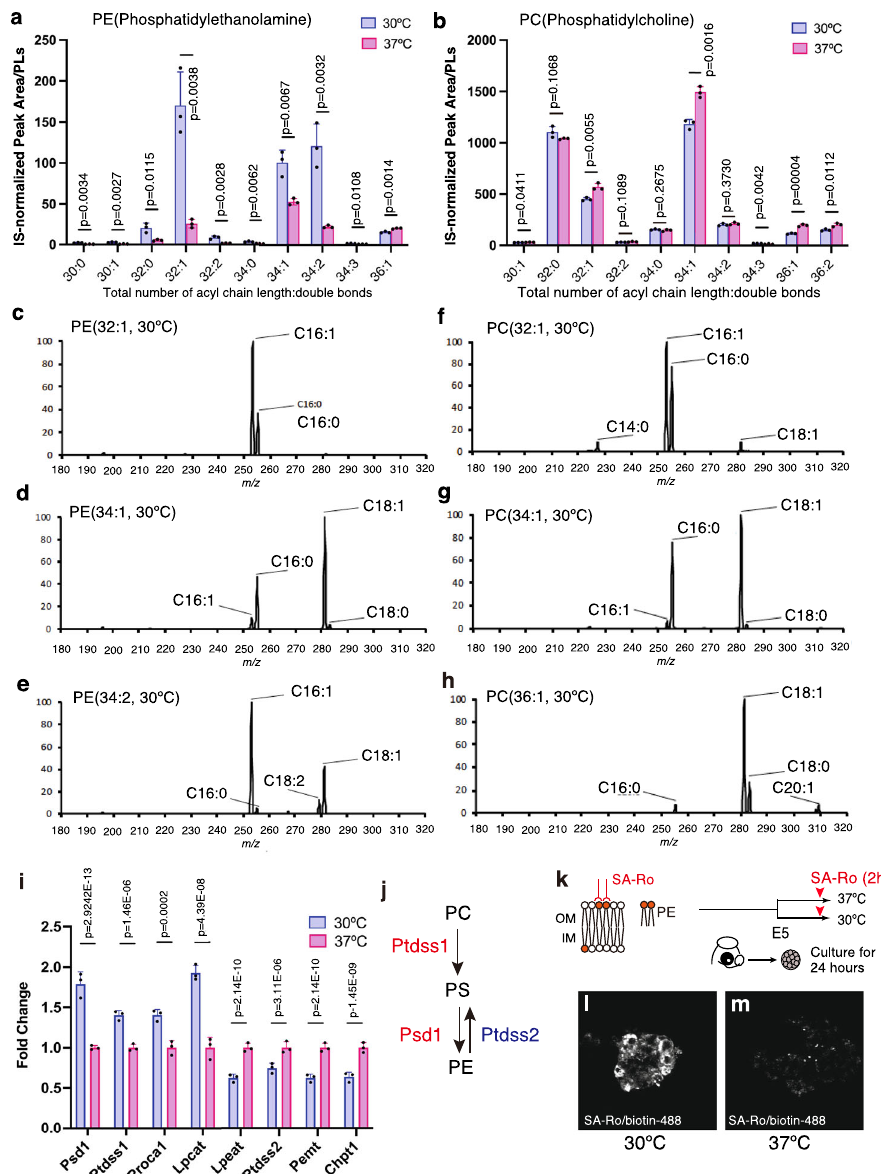
Fig. 3 Enrichment of cell surface PE mediates Notch signaling. a , b PE ( a ) and PC ( b ) molecule contents of chick neural progenitors cultured at 30 °C or 37 °C (mean + SD, n = 3 biologically independent samples in each group). c – h Fatty acid composition of PE (32:1, c ; 34:1, d ; 34:2, e ) or PC (32:1, f ; 34:1, g ; 36:1, h ) in chick neural progenitors cultured at 30 °C. i Relative expression levels of enzymes involved in PE synthesis in chick neural progenitors cultured at 30 °C or 37 °C (mean + SD, n = 3 biologically independent samples in each group). j Biosynthesis of PE through the Psd pathway. k Labeling of cell surface PE by SA-Ro treatment in nonpermeable condition. l , m SA-Ro fl uorescent labeling of chick neural progenitors cultured at 30 °C ( l ) or 37 °C ( m ). Two-sided, unpaired t -test for a , b , two-sided, negative bimodal distribution for i ( p -values were adjusted for multiple comparisons by using Benjamin – Hochberg method). P -values are indicated in each